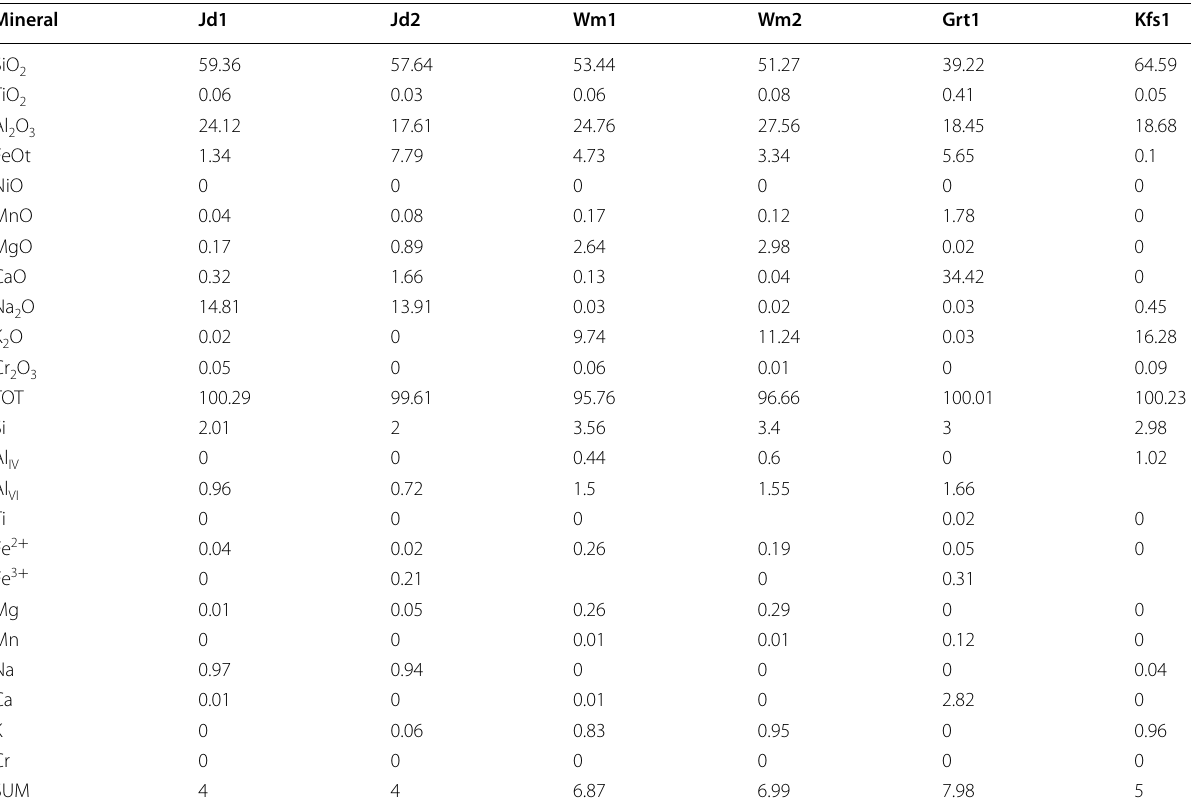
Table 7 Representative analysis of main minerals of orthogneiss (ZR19) Mineral Jd1 Jd2